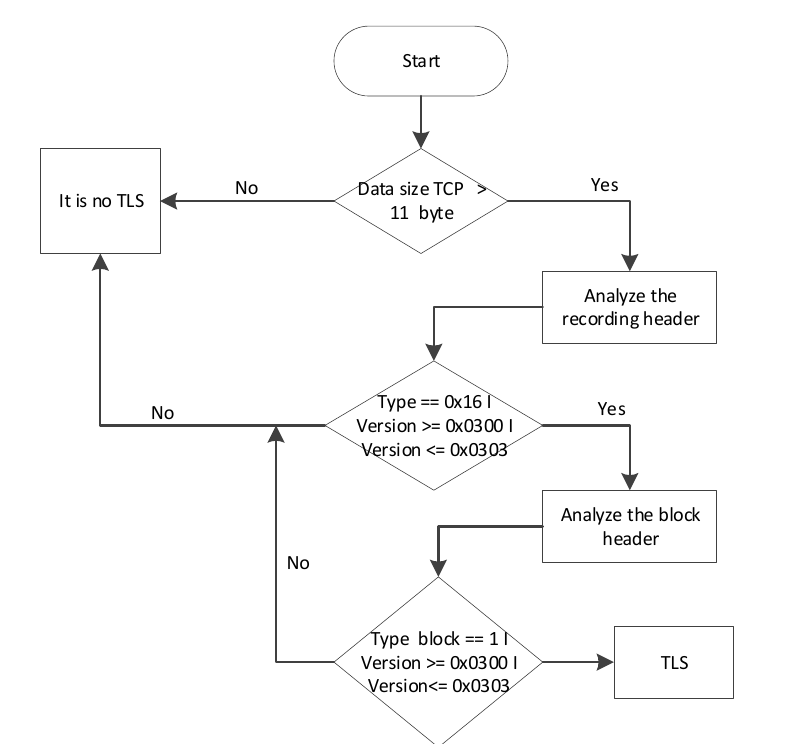
Figure 14. The algorithm of the HTTP protocol detector.